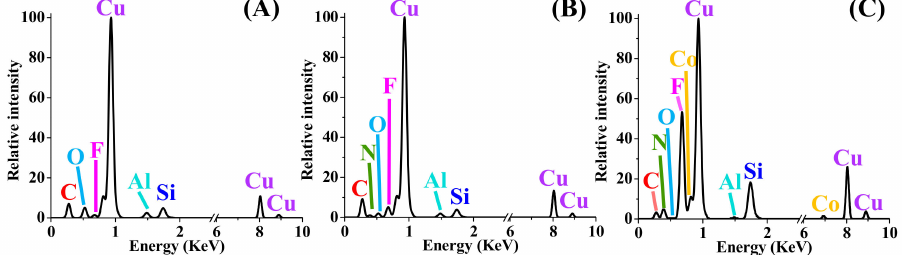
Figure 10. EDS spectra of the particles in gas emissions, where ( A ), ( B ) and ( C ) represent G#1, G#2, and G#4, respectively. Table 4. Chemical composition of particles in the gas emissions.